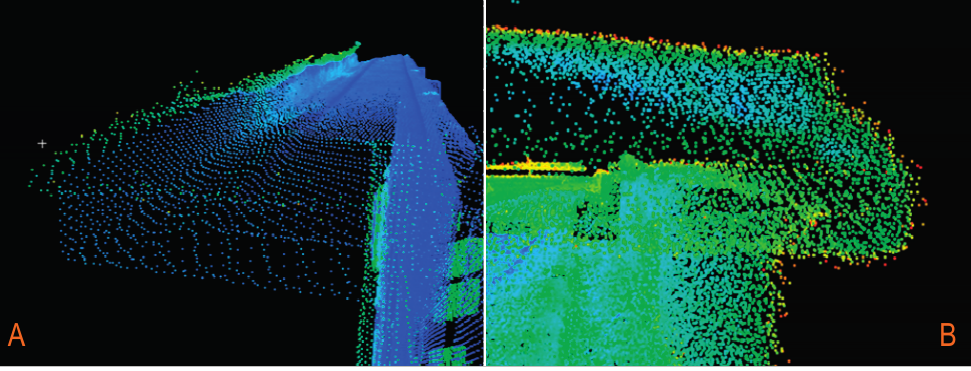
Figure 3. The view of the building’s corner. ( A ) Corner of tested building (phase laser scanner data presented in intensity colors); ( B ) The same corner of tested building (pulsed laser scanner data presented in intensity